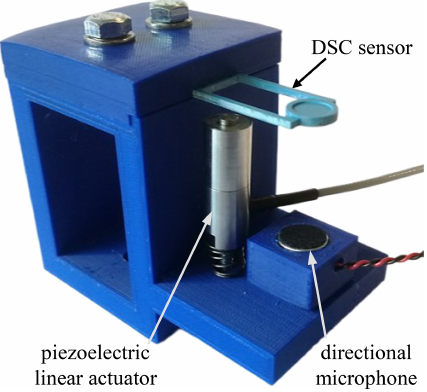
Figure 5. Setup of the acoustic measurement with the seven-layer sensor